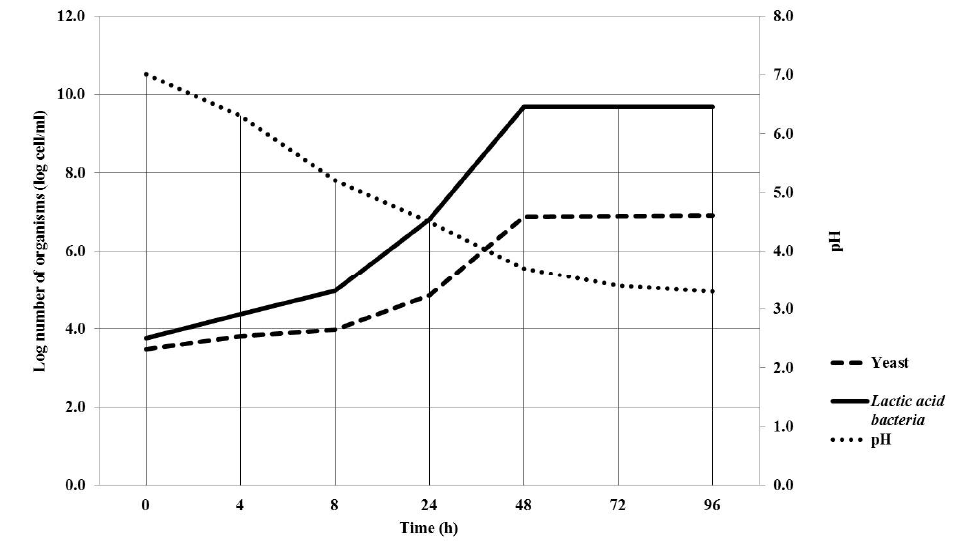
Figure 1. Yeast and LAB populations and pH changes in fermented milk at different cultivation